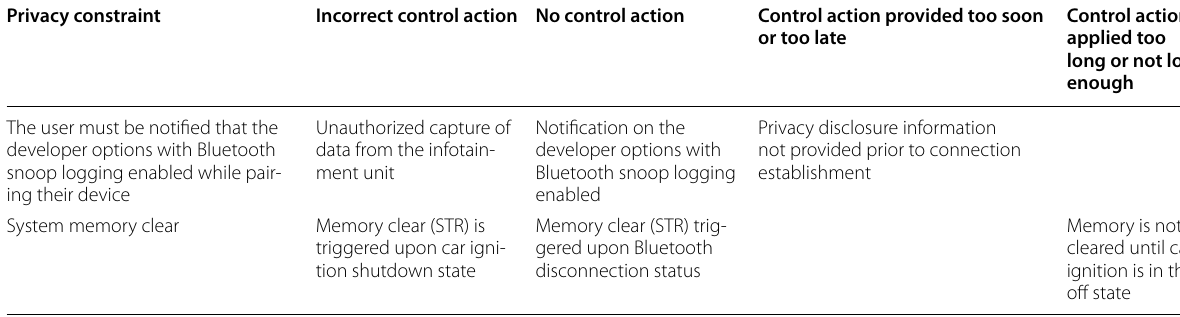
Table 2 STPA-Priv analysis of the automotive infotainment unit Privacy